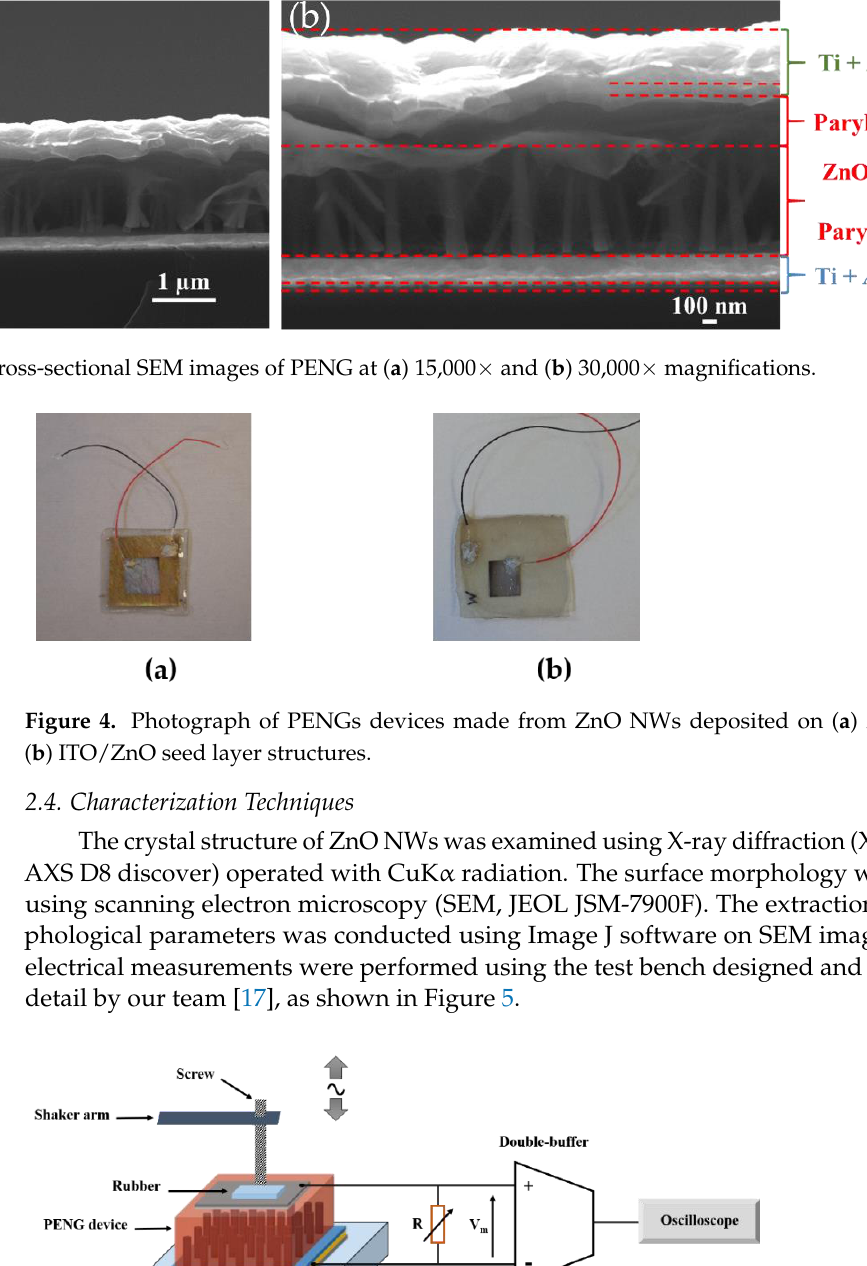
Figure 5 . Test bench for PENG performance measurement.